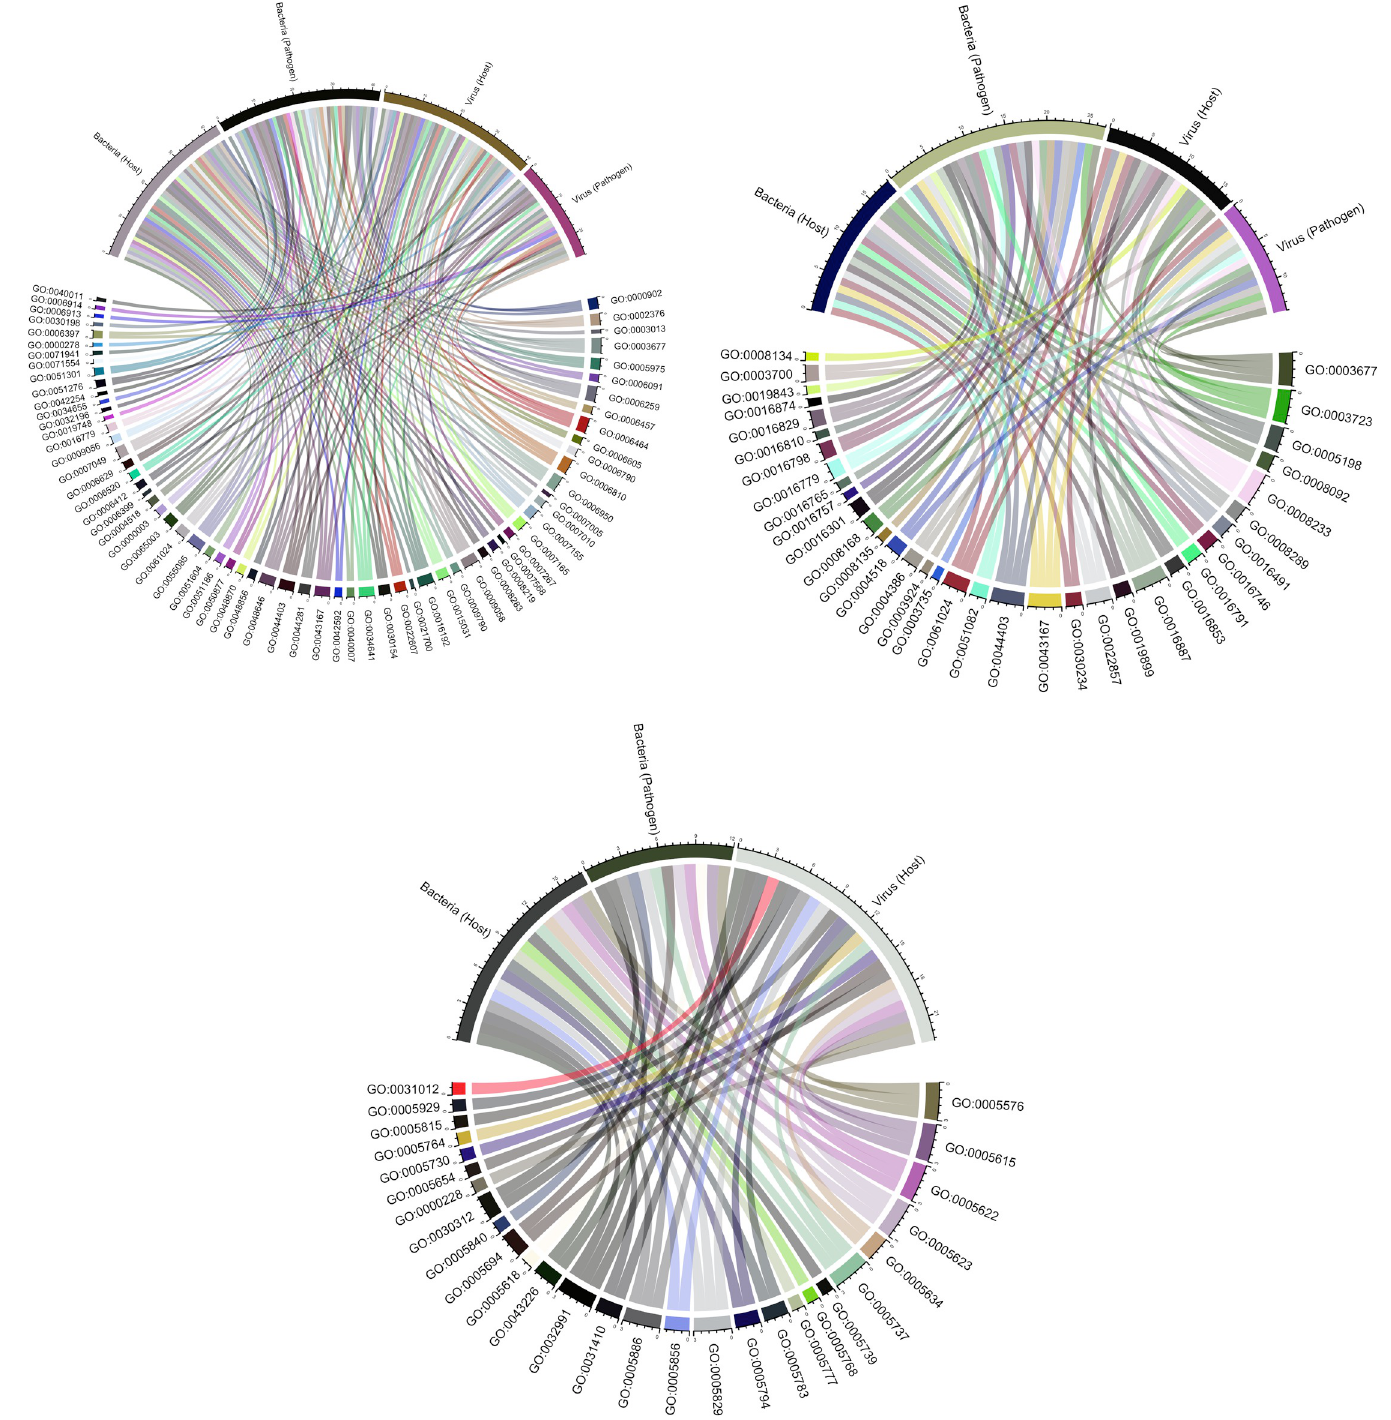
Fig 1. Chord graph representation of gene ontology based functional annotation of bacterial, viral and host mimicry proteins. The GO-term included for: (a) Biological Process, (b) Molecular Function and (c) Cellular Component. Each set is represented by a specific color.